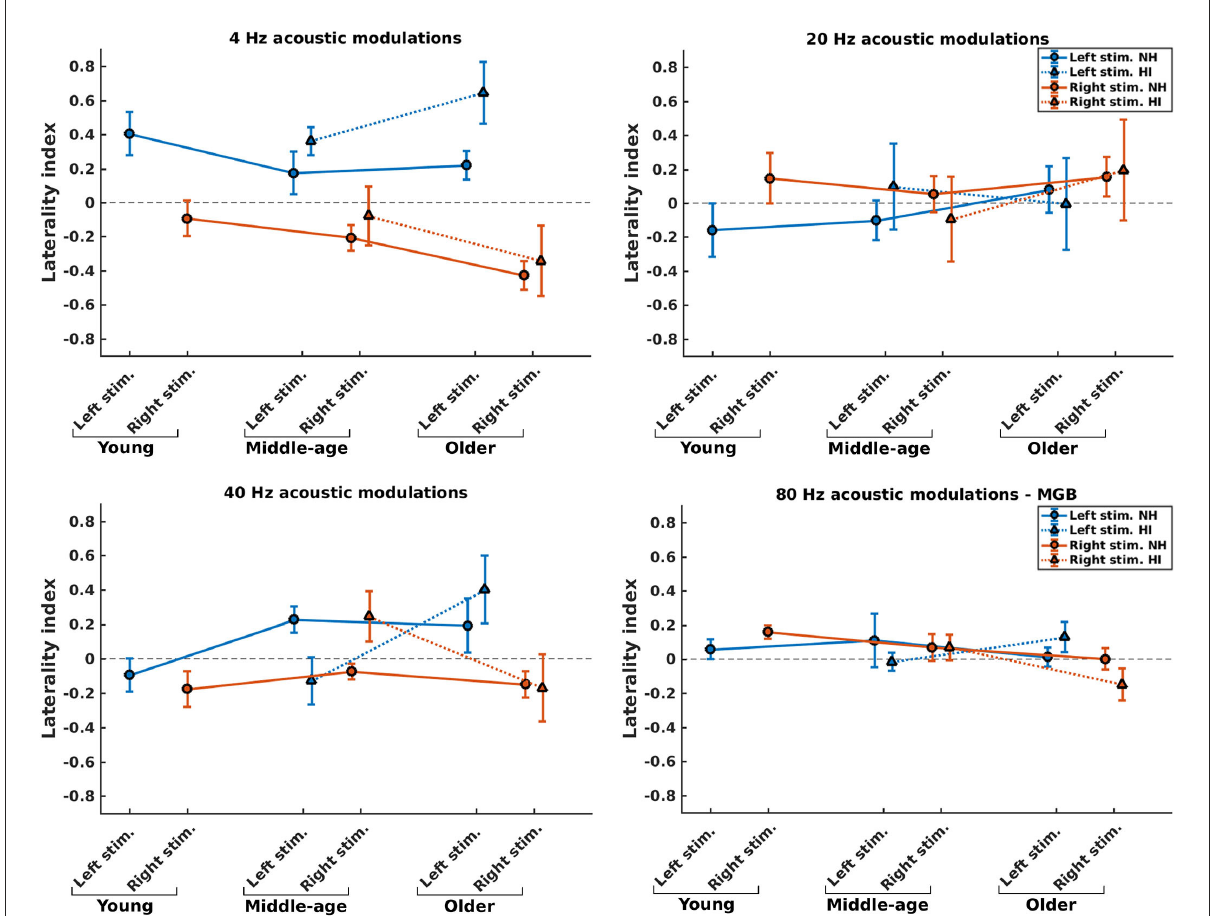
FIGURE5 Hemispheric lateralization for normal-hearing (NH) and hearing-impaired (HI) listeners (indicated by solid lines and dotted lines, respectively) in different stimulation conditions (indicated by different colors) and different age groups. For 4, 20, and 40Hz stimuli, the laterality indexes (LIs) were calculated based on the auditory cortex (AC), while for 80Hz stimuli the LIs were calculated based on the medial geniculate body (MGB). The error bars illustrate the estimated standard deviations using the jackknife method